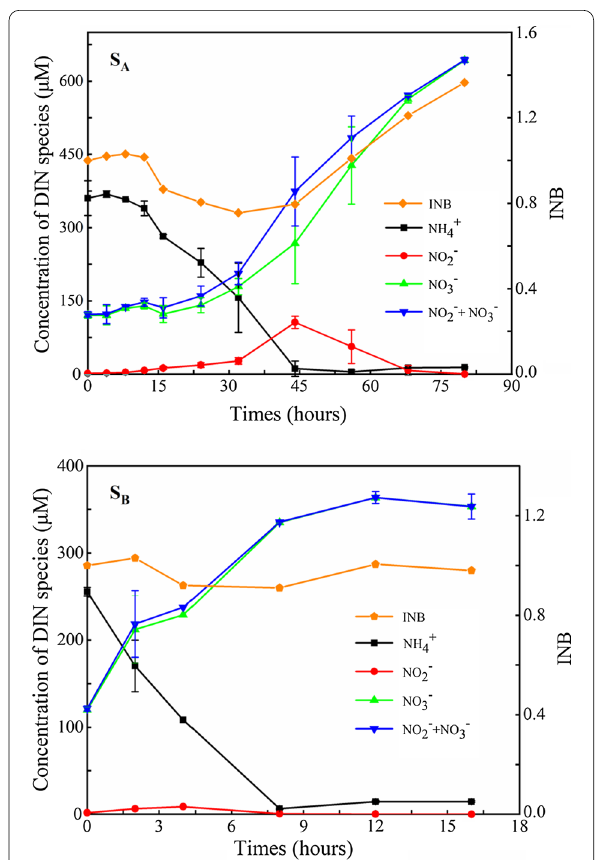
Fig. 3 Time series for the concentrations of ammonium, nitrite and nitrate in the activated sludge of the aeration tank in Xinfeng WWTPs. Error bars represent standard variation (SD, n =